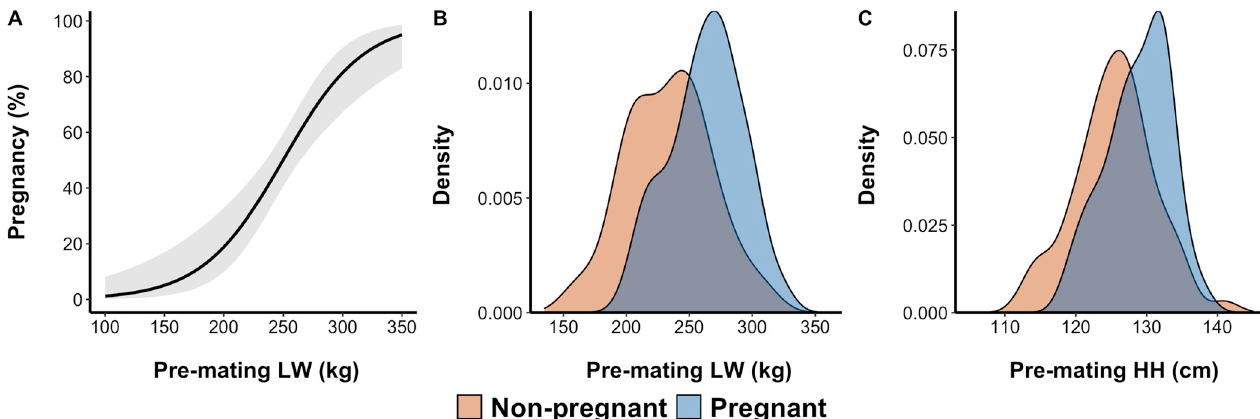
Fig 2. Effect of pre-mating liveweight (LW) on the likelihood of pregnancy, expressed as a percentage, (A) and kernel density estimation plots of pre-mating LW (B) and pre-mating hip height (HH; C) of non-pregnant and pregnant crossbred Brahman heifers. Weaning weight group and its interaction with pre- mating LW was initially included in the model describing the effect of pre-mating LW on pregnancy percentage and since it was not significant ( P = 0.71 and P = 0.90 respectively) a single model was created using data from early and normally weaned heifers. The model represented in A is described by Eqs 1 and 2 and grey shaded area represents the 95% confidence interval around the fit. Pre-mating LW and HH were recorded on 30-Oct-2015 and natural mating occurred between 05-Jan-2016 to